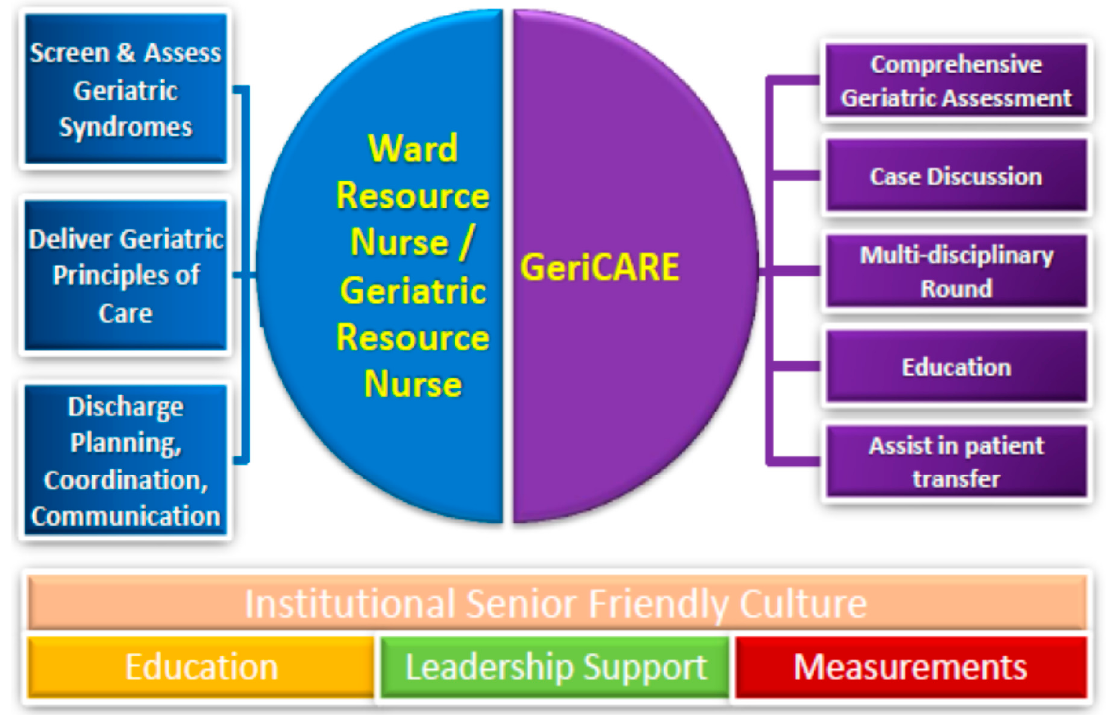
Figure 3. Overview of the Framework for Inpatient care of the Frail Elderly (FIFE) model ( Reproduced with permission from Associate Professor Tan Thai